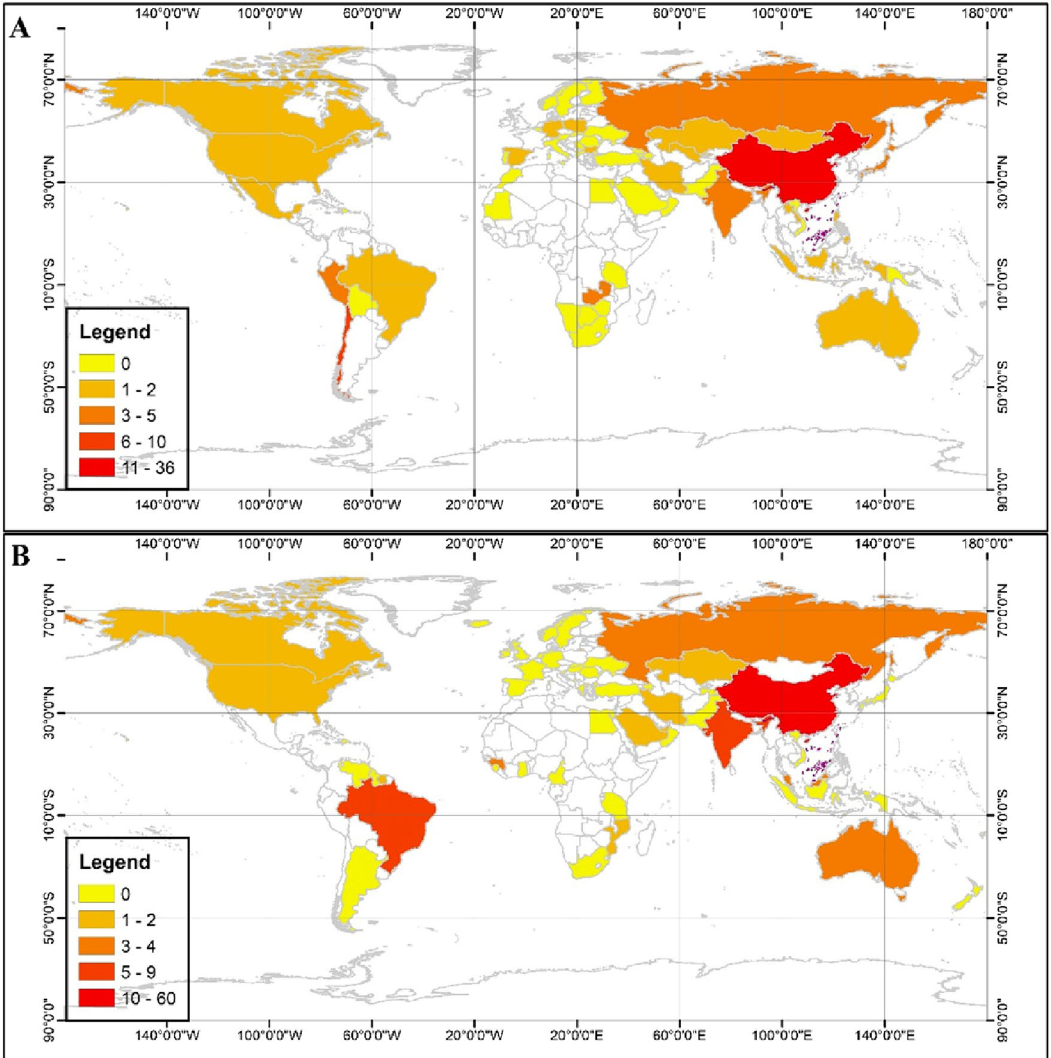
Fig. 4 Multi-national environmental-risk (ER) interpretation. a Copper. b Aluminum. These assessments are conducted for all countries, which contributed to production copper and aluminum SRR indicators (GII and EFI) for a broad range of countries are shown in the Supplementary Information,